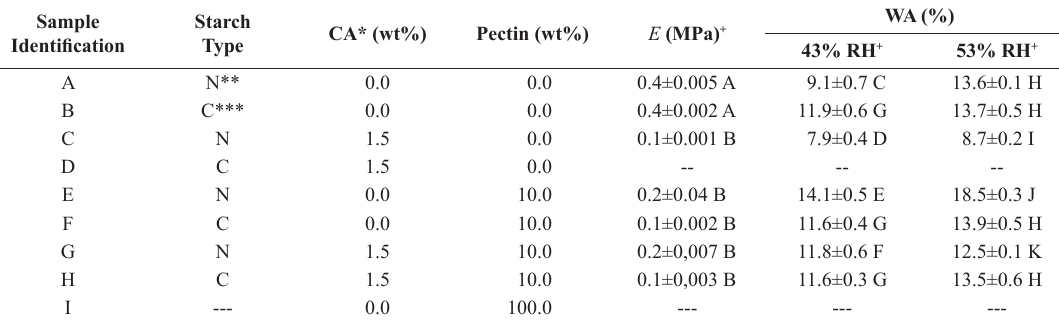
Table 1. Composition and properties of WA and Young’s Modulus ( E ) of polymeric